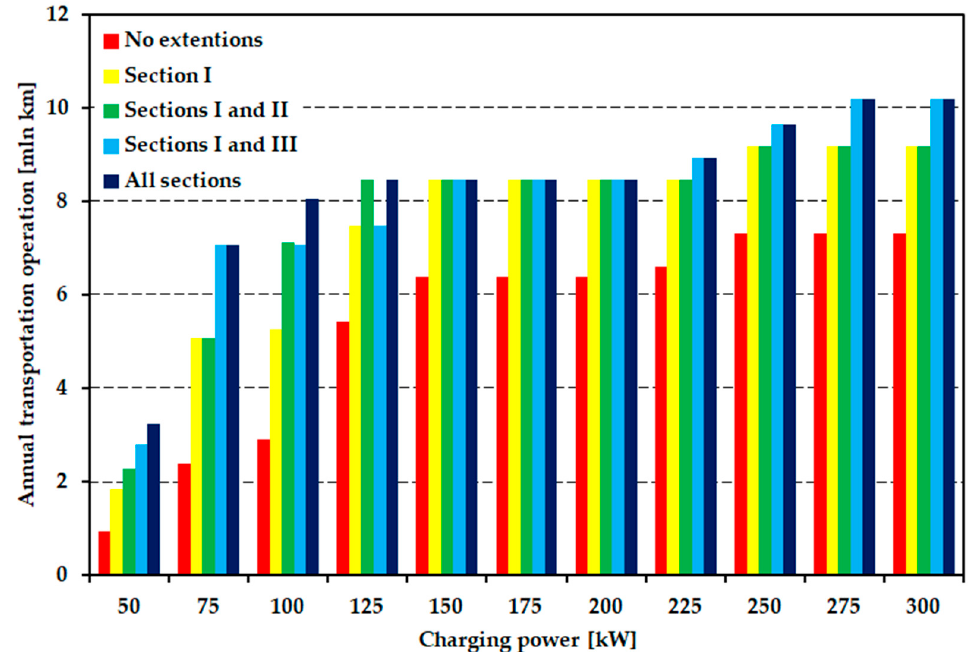
Figure 11. The value of the sensitivity coefficient (source: own elaboration).